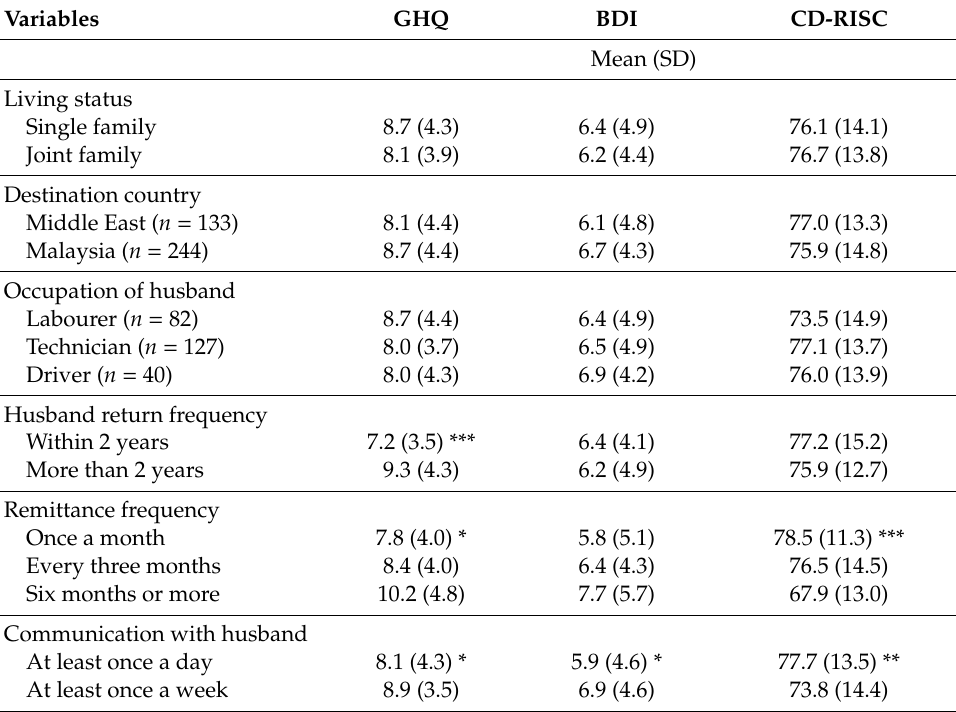
Figure 1. Mean General Health Questionnaire (GHQ) and Beck Depression Inventory (BDI) scores of participants aged below and above 30 years. Table 3. Bivariate associations of mean GHQ, BDI, and Connor–Davidson Resilience Scale (CD-RISC) scores with migration-related